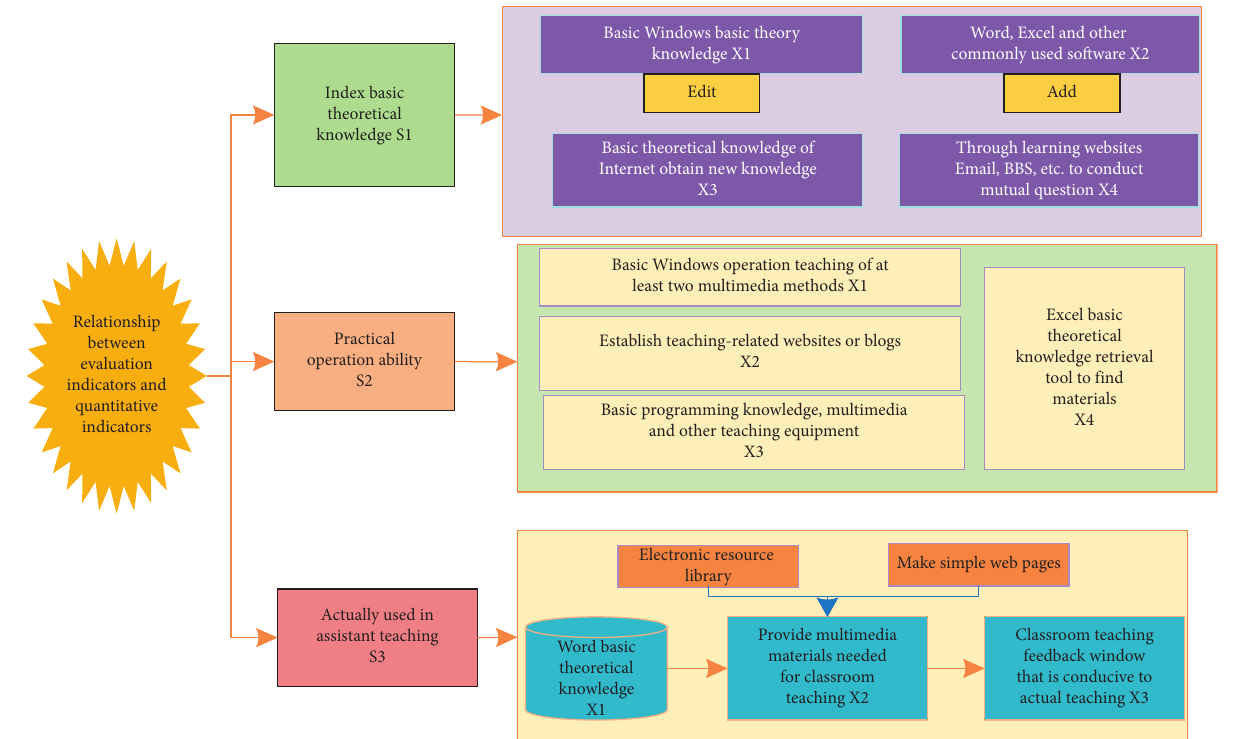
Figure 1: Relationship between evaluation indicators and quantitative